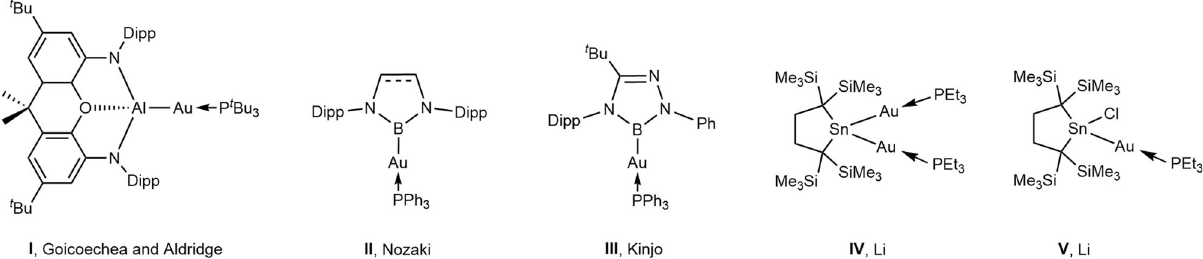
Fig. 1 Selected examples of Au – E bond species. Gold complexes bonded to metal and metalloid elements I – IV possessing the nucleophilic auride